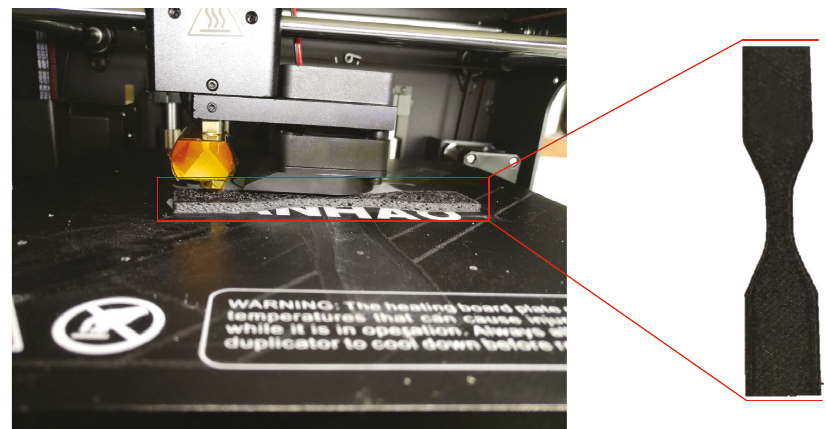
Figure 12: FFF 3D printed specimen from the ABS/GO composite filament.